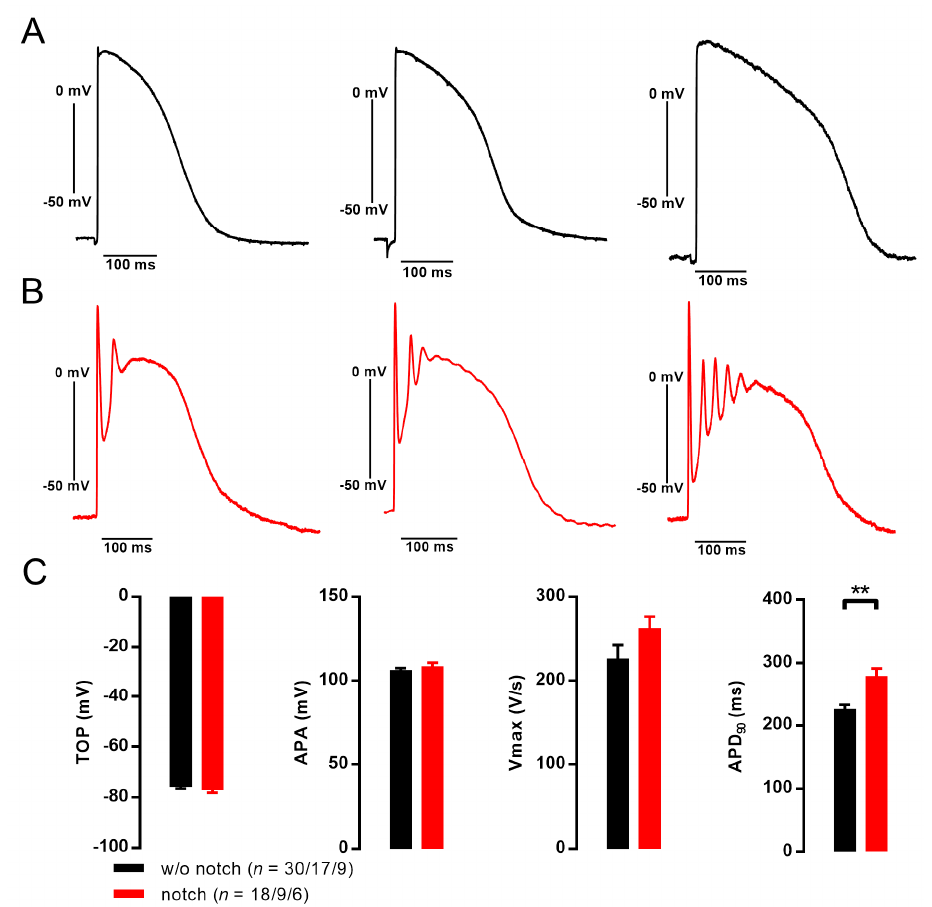
Figure 2. Pronounced notch with oscillation in the plateau phase of action potential (AP) recorded from engineered heart tissue (EHT) derived by C25 human induced pluripotent stem cell-derived cardiomyocytes (hiPSC-CMs). ( A ) Original AP recordings without ( A ) and with ( B ) notch followed by oscillating afterdepolarizations in EHT from cell line C25. ( C ) Summary of the results for take-off potential (TOP), AP amplitude (APA), maximum upstroke velocity (V max ), AP duration at 90% repolarization (APD 90 ), ** p < 0.01, unpaired Student’s t test; n = number of impalements/number of EHTs/number of individual differentiation batches.